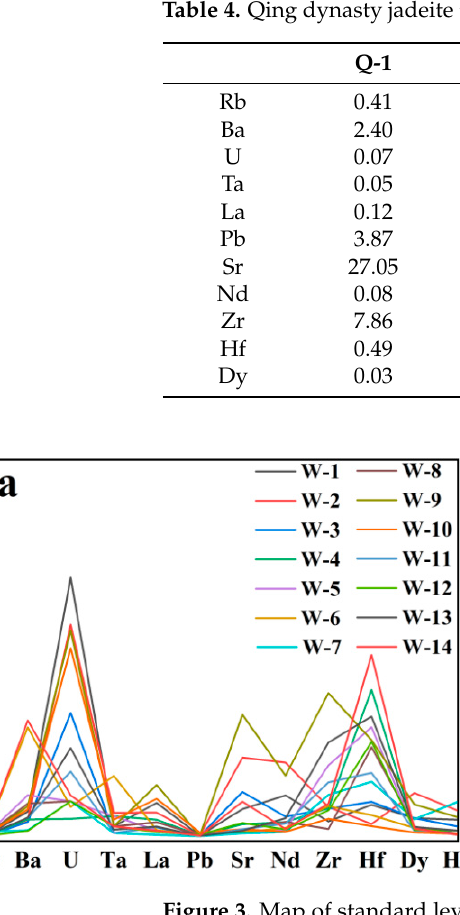
Table 4. Qing dynasty jadeite trace elements (ppm).